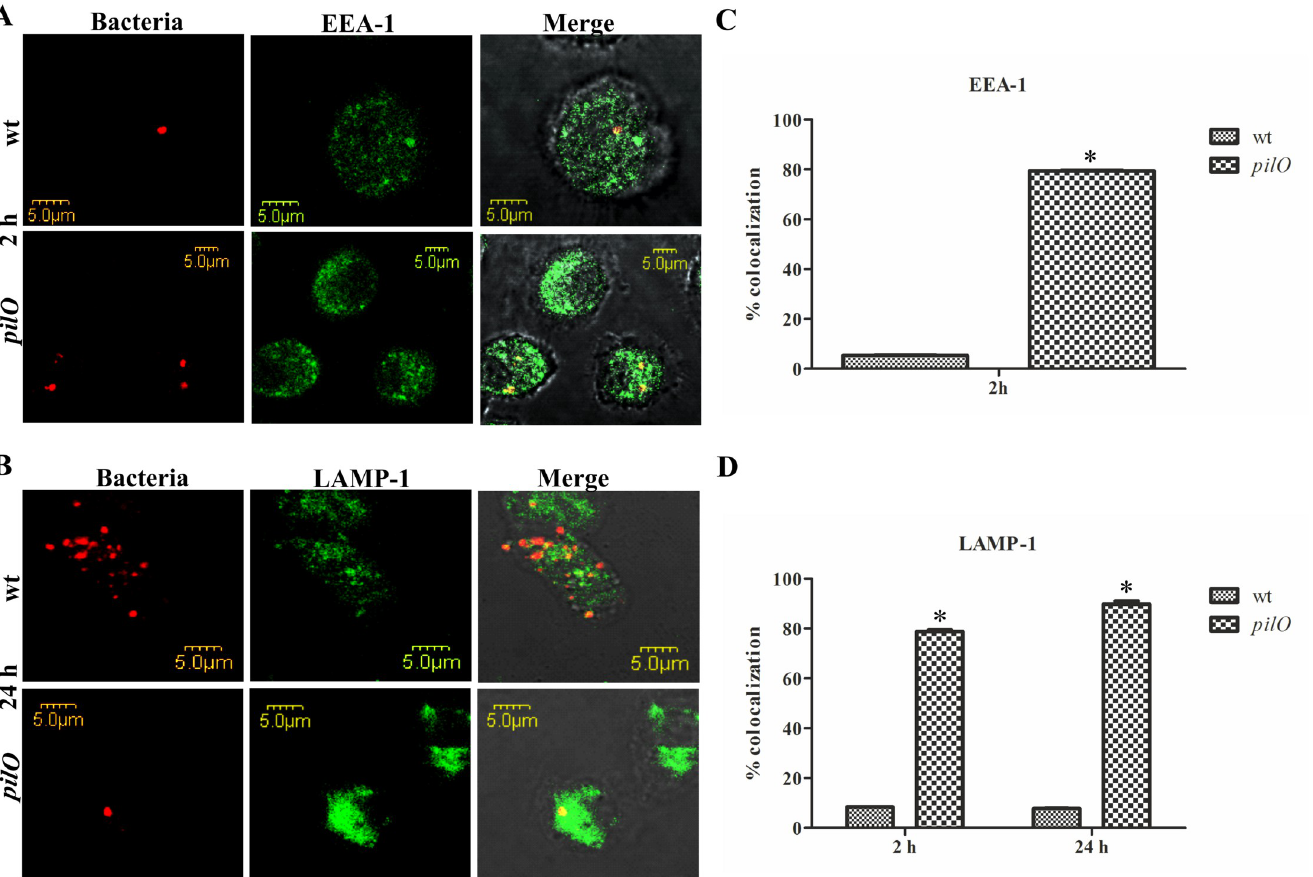
Fig 6. Trafficking of the pilO mutant strain within HMDMs. Shown are representative confocal laser scanning microscopy images, demonstrating the colocalization of wt F . novicida or the pilO mutant with the endosomal markers EEA-1 (A) or LAMP-1 (B) , where bacteria are labelled red and the markers green. Quantitative analyses of the EEA-1 (C) and LAMP-1 (D) expression by the FCPs within HMDMs. All results are based on analyzing 100 infected cells from three coverslips, with the error bars representing the standard deviations. The results shown within panels A and B are a representative of three independent experiments, while the panels C and D are showing the average data of three independent experiments. Asterisks denote that the colocalization of the pilO mutant is statistically different from that of wt F . novicida , as determined by Student t- test ( � , p < 0.05).